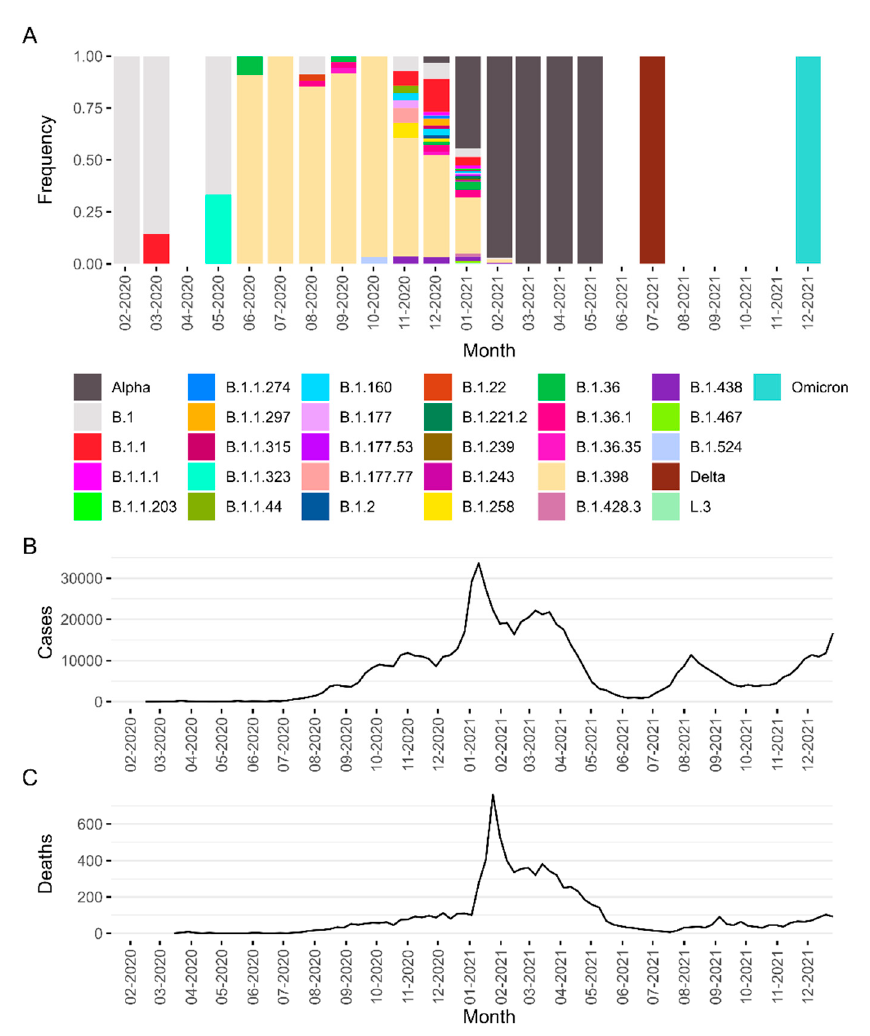
Figure 1. Epidemics of COVID-19 in the first two years of the pandemic in Lebanon. In ( A ), we see the relative frequency of SARS-CoV-2 lineages sampled in Lebanon between February 2020 and December 2021. Lineages belonging to the variants of concern Alpha, Delta, and Omicron are grouped under these labels. The numbers of COVID-19 cases and deaths are described in ( B ) and ( C ).